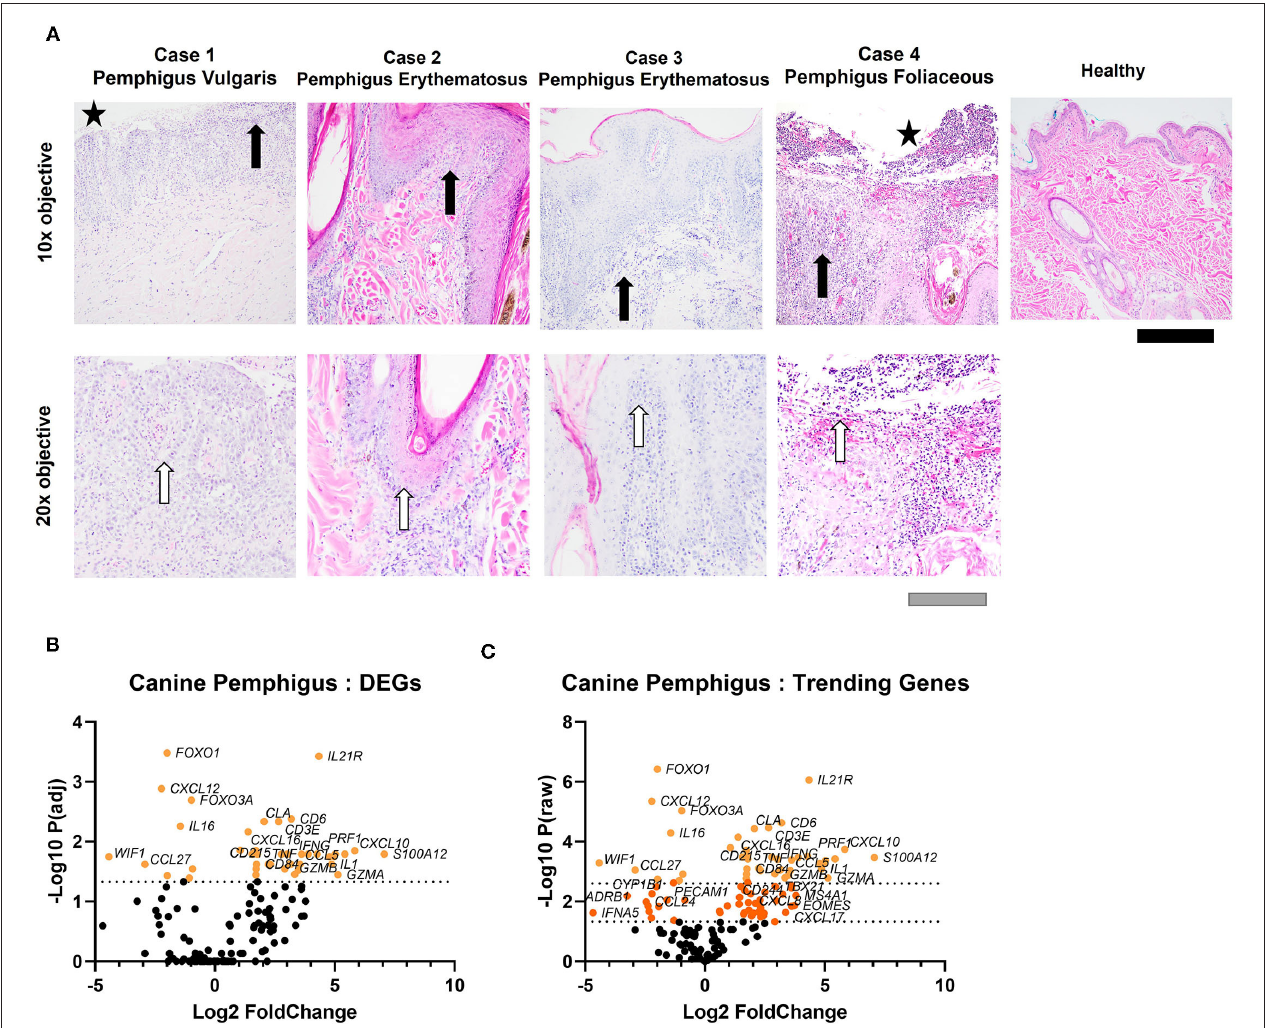
FIGURE 1 | H&E staining of canine pemphigus and healthy canine skin reveals histopathologic features of pemphigus variants. (A) All cases revealed interface dermatitis, edema, and pigmentary incontinence at the dermo-epidermal junction (black arrows indicate interface dermatitis). Case 1, pemphigus vulgaris, and case 4, pemphigus foliaceous, revealed epidermal sloughing (black stars). Polymorphonuclear cells were noted in all biopsies (white arrows). Scale bars black = 100 µ m, gray = 200 µ m. (B) Volcano plot of differential gene expression (DEG) analysis in canine pemphigus vs. healthy skin margins using BY adjusted P -values or (C) raw P -values ( n = 4 pemphigus cases and 5 healthy margin